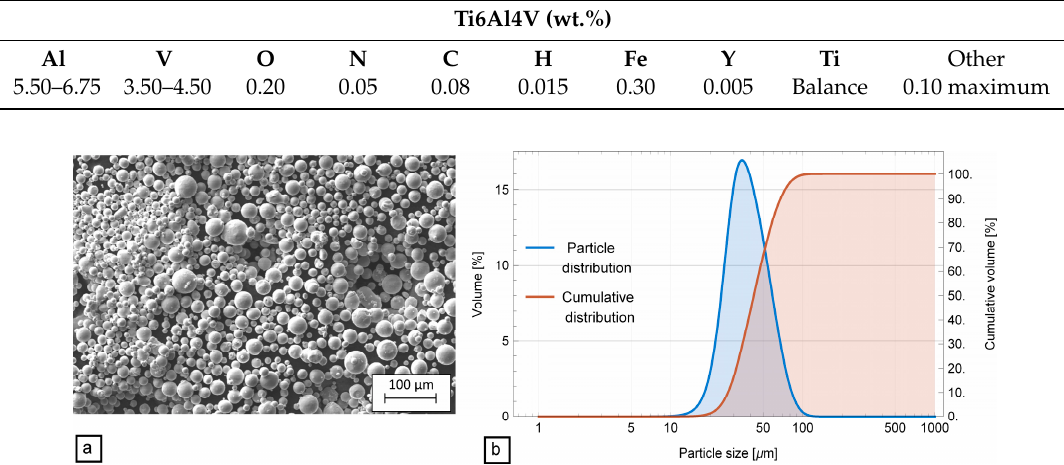
Table 1. Chemical composition of Ti64Al4V.